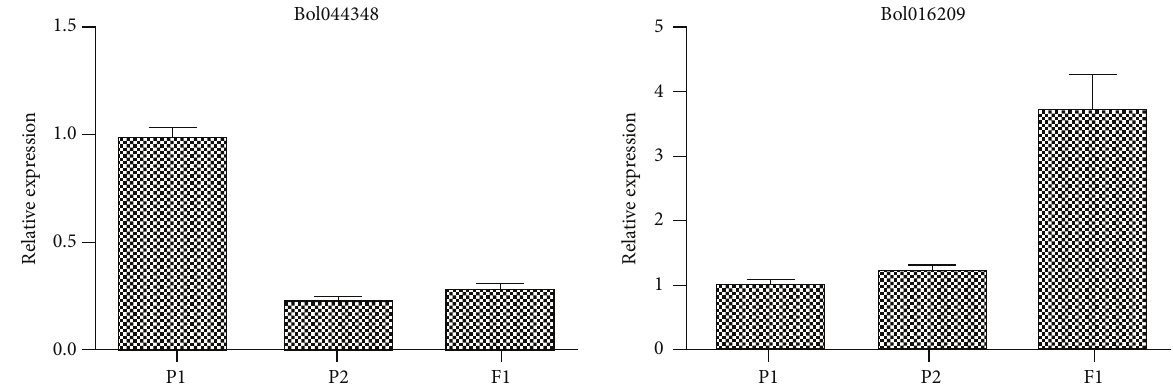
Figure 7: Genes with expression levels validated by